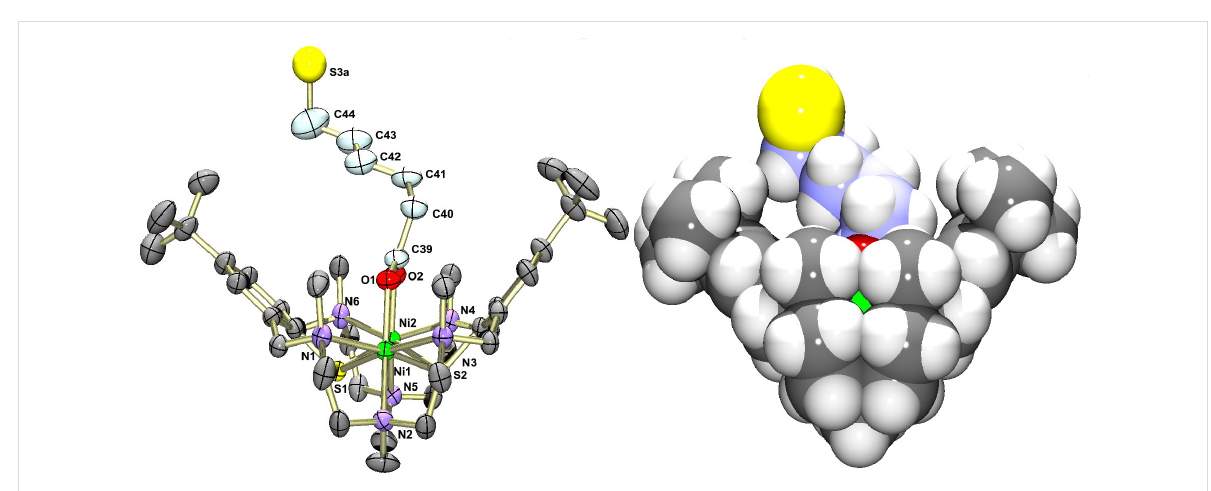
Figure 2: ORTEP (left) and van der Waals representations (right) of the molecular structure of the [Ni 2 L(O 2 C(CH 2 ) 5 SH)] + cation in crystals of 6 . The accessibility of the thiol head group (atom labeled S3a) is obvious from this view.